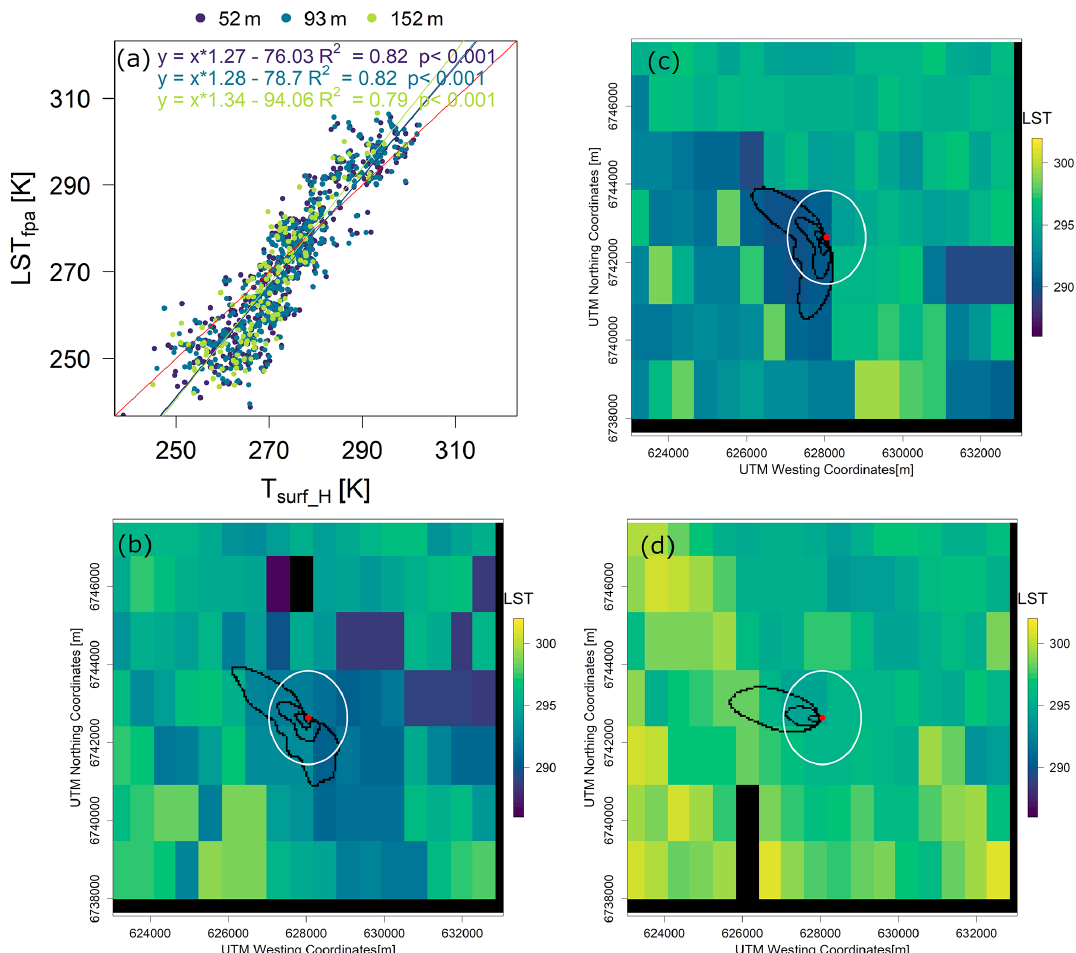
Figure 10. Relationship between MODIS AQUA day LST fpa and surface temperature ( T surf_H ) calculated from the inverted sensible heat flux (details about the methods in Appendix D). The red line represents the 1 : 1 line. Panels (b) to (d) show example footprints at the three levels (black lines) overlaid on the LST map from 31 May to 2 June 2017, respectively. Non-original low-quality LST values are blacked out. The white circle indicates the 1km diameter around the